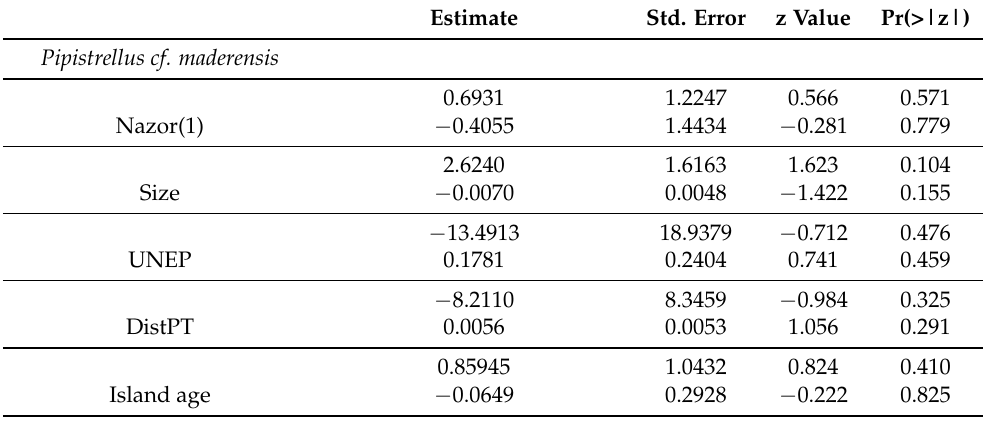
Table A2. Parameters of the univariate GLM full models (including intercept) relating island char- acteristics and the occurrence of P. cf. maderensis (top) and N. azoreum (bottom). All variables are described in Table A1. Nazor and Pmade are binomial categorical variables with absence as